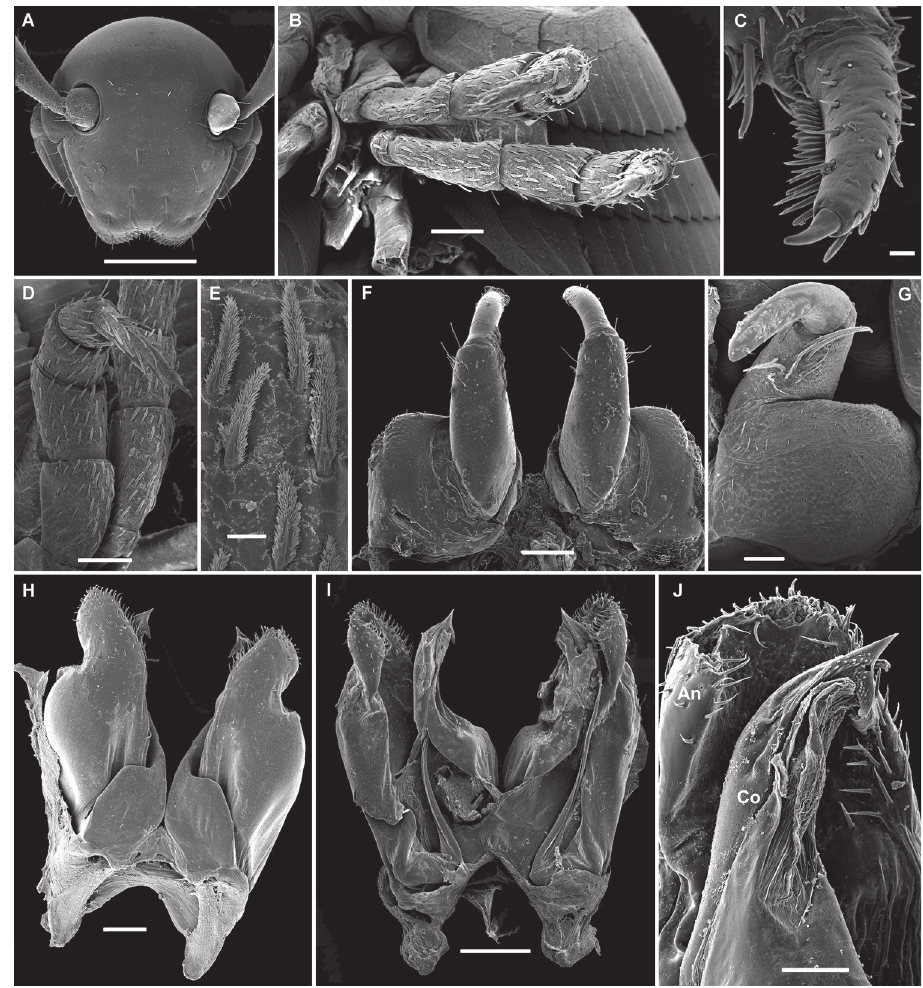
Figure 2. Stemmiulus uncus Nzoko Fiemapong & VandenSpiegel, sp. n. ♂ paratype (SEM). A head front view B, D 3 and 4 leg-pairs C detail of telopodite of 3 leg-pair; E detail of spatulate setae on the 3 leg-pair F, G leg-pair two, oral and caudal views, respectively H, I leg-pair 8 (gonopods) oral and caudal views respectively J apical part of right gonopod showing angiocoxite ( An ) surrounding colpocoxite ( Co ) Scale bars 500 µm ( A ), 100 µm ( B, D, F, H, I ), 50 µm ( G, J ), 20 µm ( C